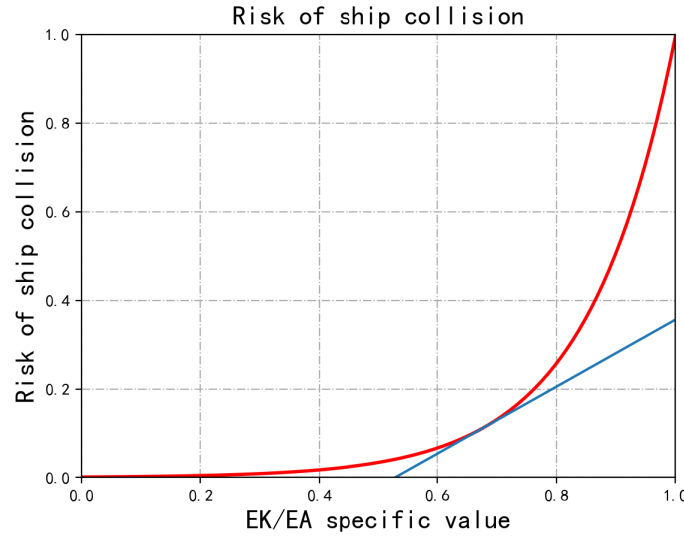
Figure 4. Danger curve of ship collision with bridge.